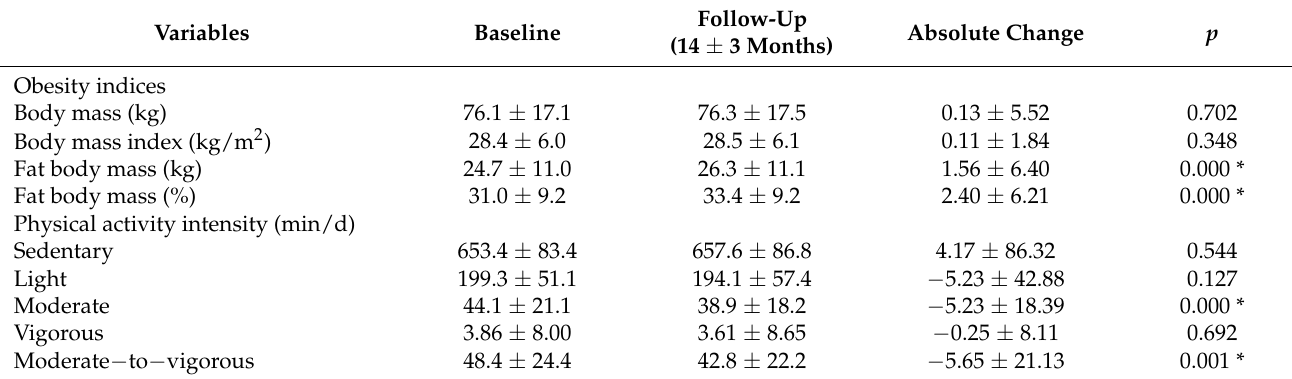
Table 2. Absolute changes in obesity indices and physical activity intensities after the follow-up ( n =